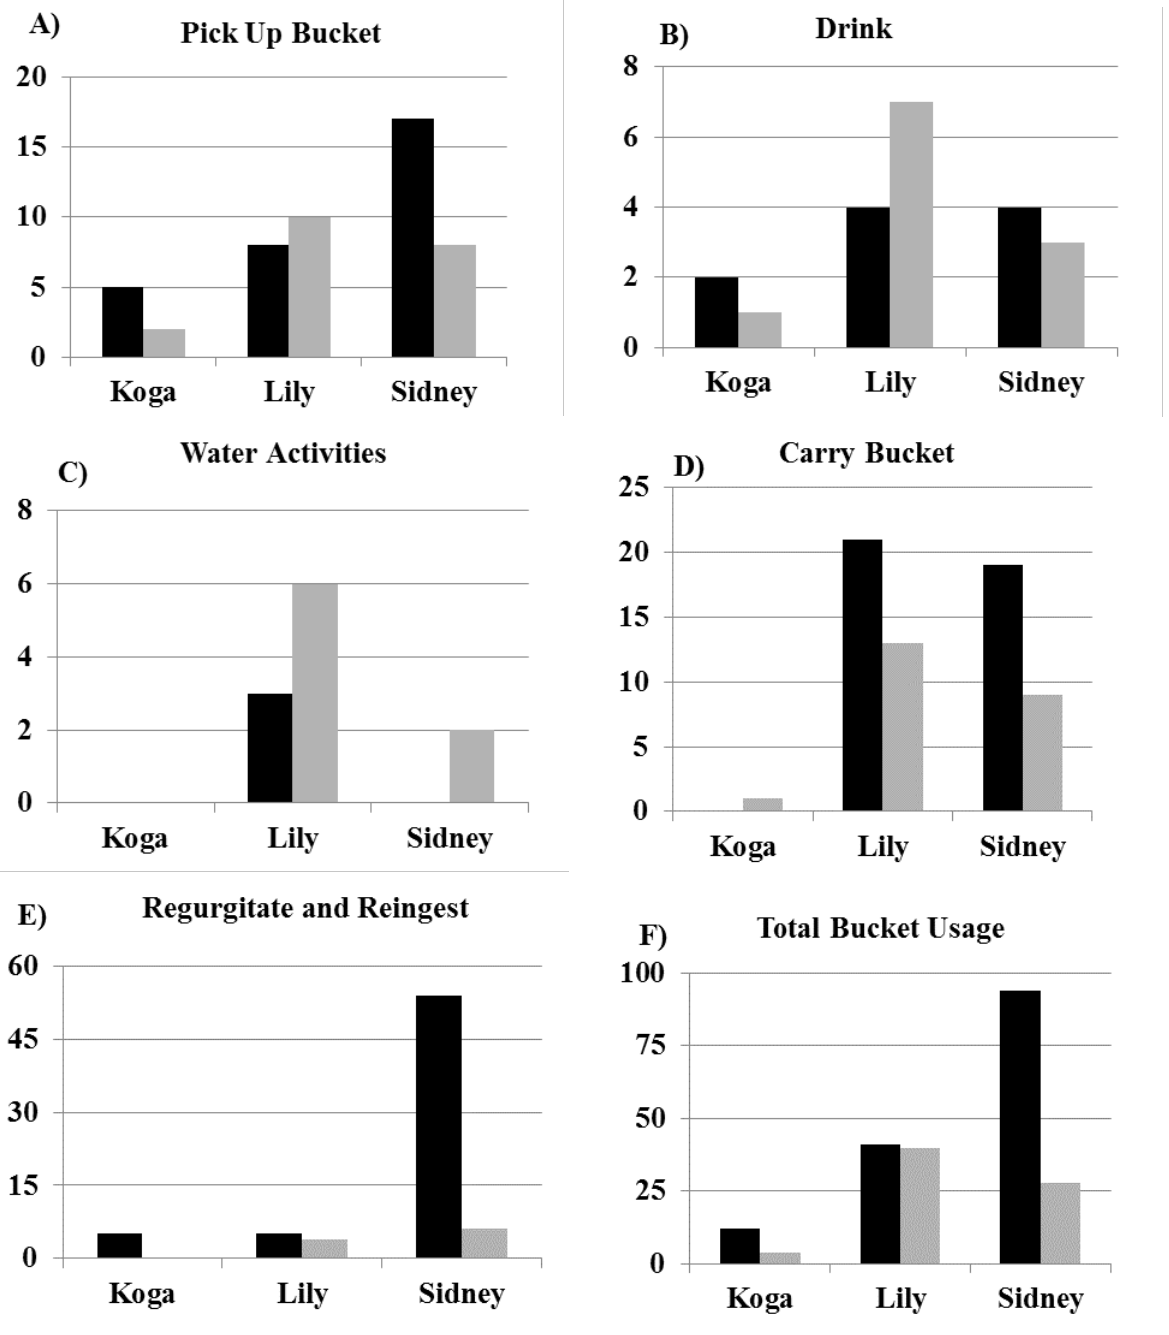
Figure 1 . Frequency of bucket usage behaviors by three gorillas (x axis): A. Pick up bucket; B. Drink from bucket; C. Water activities; D. Carry; E. Regurgitate and Reingest; F. Total bucket usage. The Y axis indicates number of occurrence of the behavior. Black bars = functional buckets; gray bars = non-functional